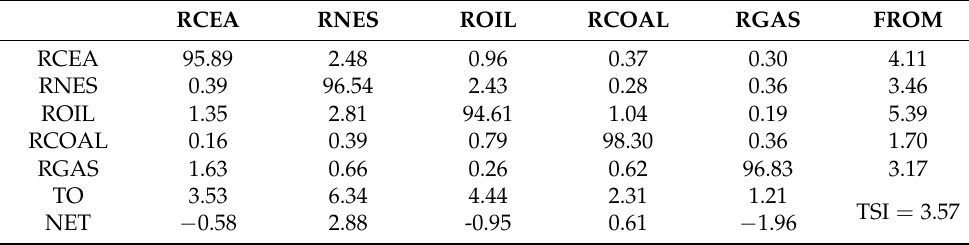
Table 3. The connectedness matrix of the original return